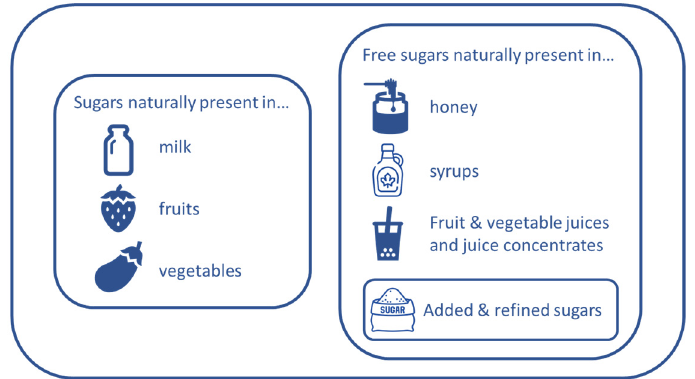
Figure 1 . Schematic description of total sugars, free sugars and added